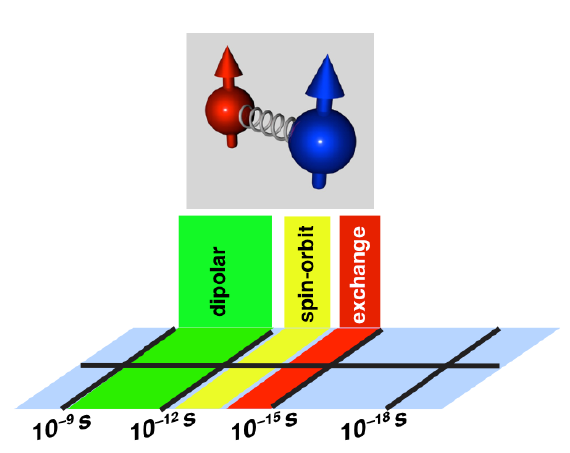
Figure 1: Fundamental interactions and relevant time scales in magnetism and